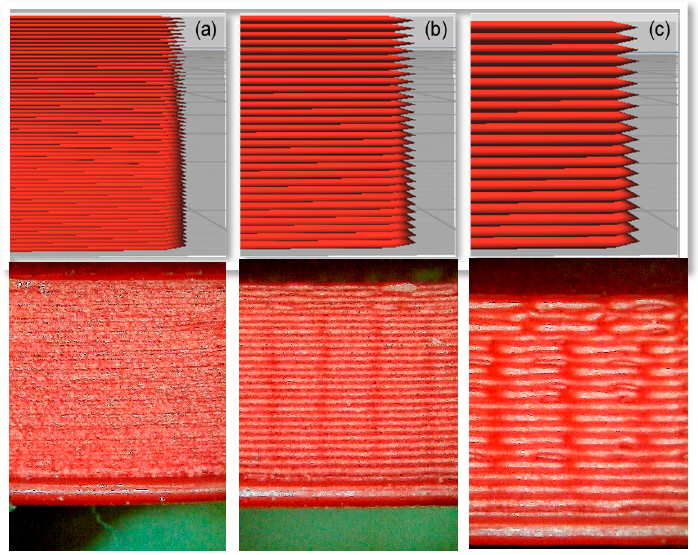
Figure 2. Three different layer thicknesses: ( a ) 0.05 mm; ( b ) 0.10 mm; ( c ) 0.15 mm [33].